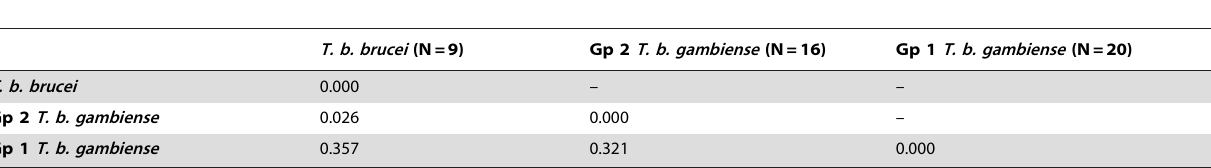
Table 3. Nei’s genetic distance between the populations of group 1 and 2 T. b. gambiense and T. b. brucei at the Coˆte d’Ivoire focus.